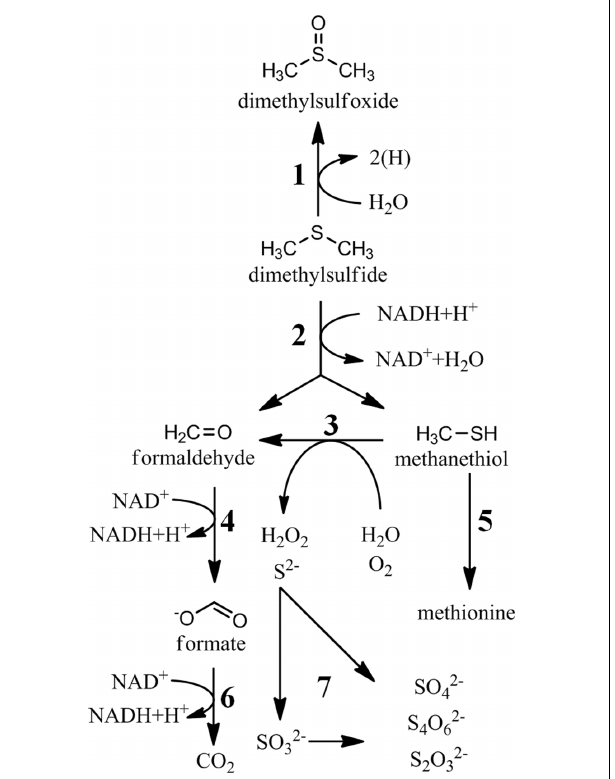
FIGURE 4 | Bioconversions of dimethylsulfide and methanethiol. 1, DMS dehydrogenase; 2, DMS monooxygenase; 3, methanethiol oxidase (E.C. 1.8.3.4); 4, formaldehyde oxidation (various enzymes); 5, cystathionine γ -synthetase (E.C. 2.5.1.48); 6, formate dehydrogenase (E.C. 1.2.1.2); 7, sulfide oxidation (many